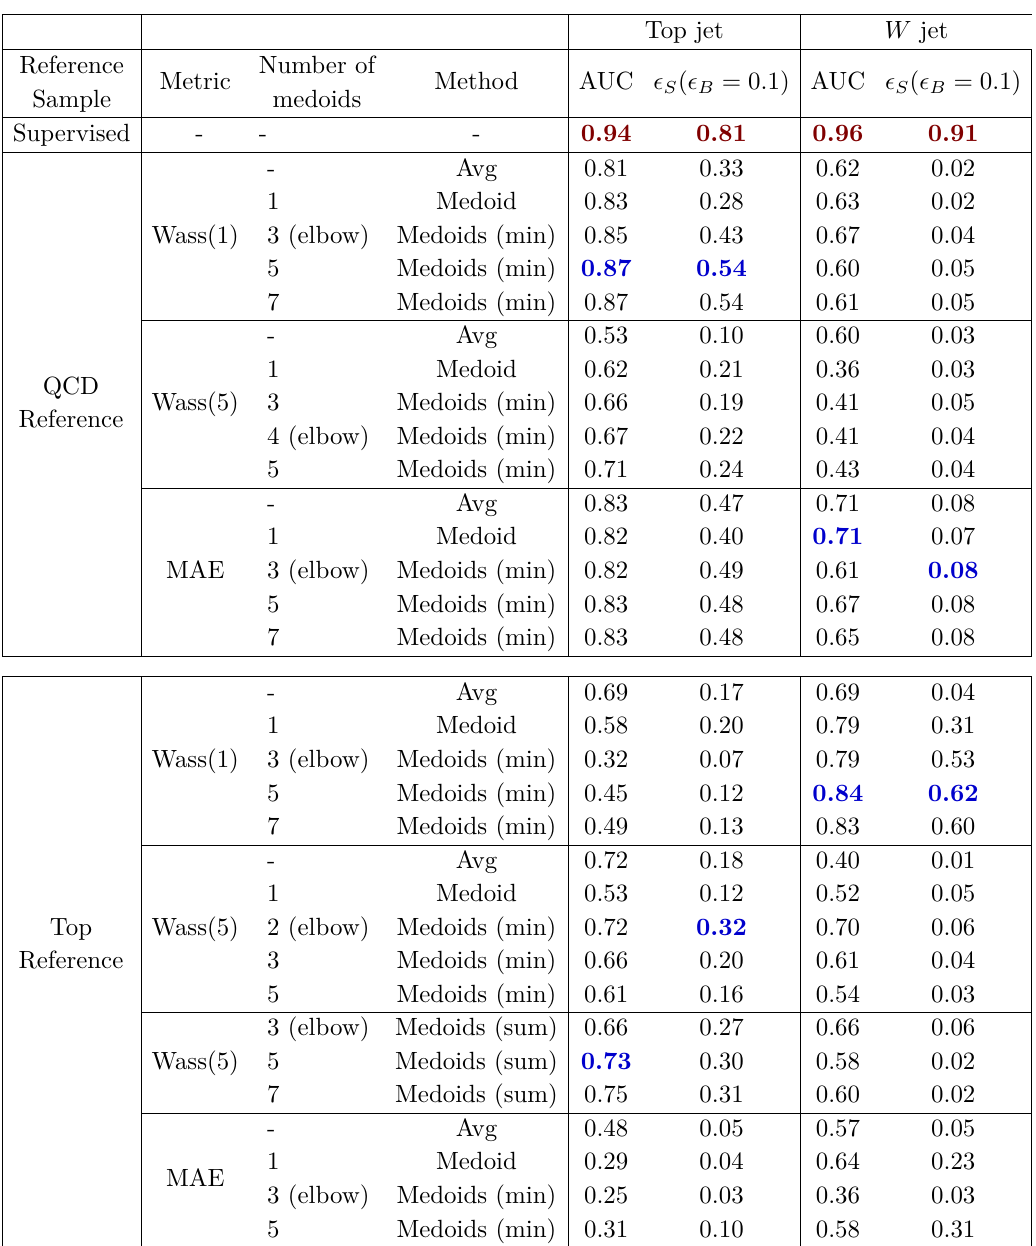
Table 2 . Results for QCD vs. signal classification, with signal labeled in the top row. Top rows use a QCD reference sample, and bottom rows use a top reference sample (assuming W events are more “top-like” than QCD events). When there are multiple medoids, distances are combined either by taking the minimum or the sum of the distances to the k different medoids, as denoted in the table. Medoids are selected with the same metric as the one used to compare images. For each metric,